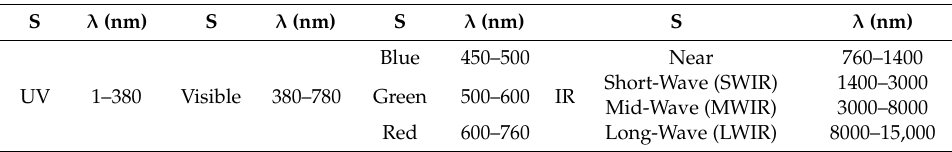
Table 1. Spectrum (S) and wavelengths λ (nm).